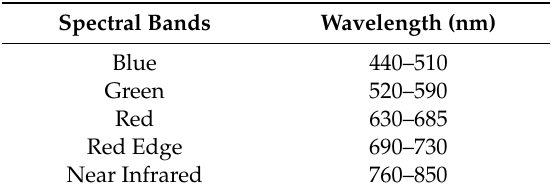
Table 1. Spectral bands and their respective range of wavelengths for RapidEye imagery. Spectral Bands Wavelength (nm) Blue 440–510 Green 520–590 Red 630–685 Red Edge 690–730 Near Infrared